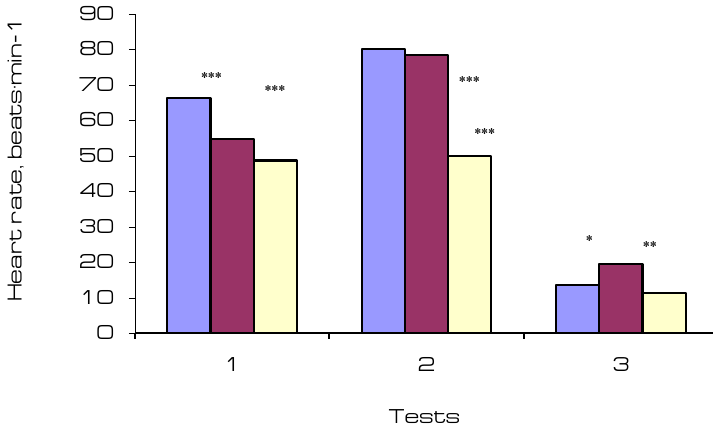
Fig.1. Indicators of ortho-static test of elite sportsmen, who specialize in speed rock-climbing (n=10), complex rock- climbing (n=10) and mountaineering (n=6): Heart rate, b.p.m -1 -